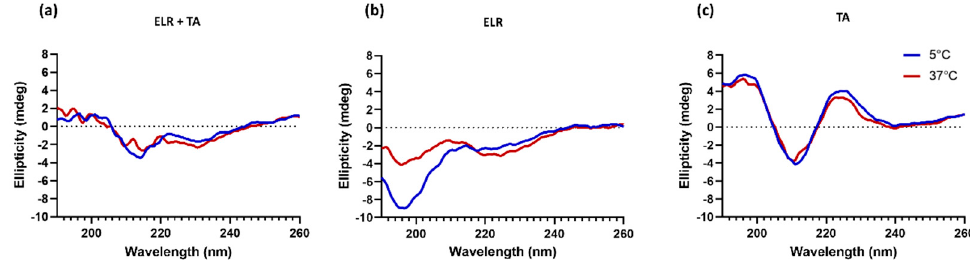
Figure 3. Secondary structure characterization by circular dichroism spectroscopy of ( a ) ELR + TA, ( b ) ELR, and ( c ) TA solutions.